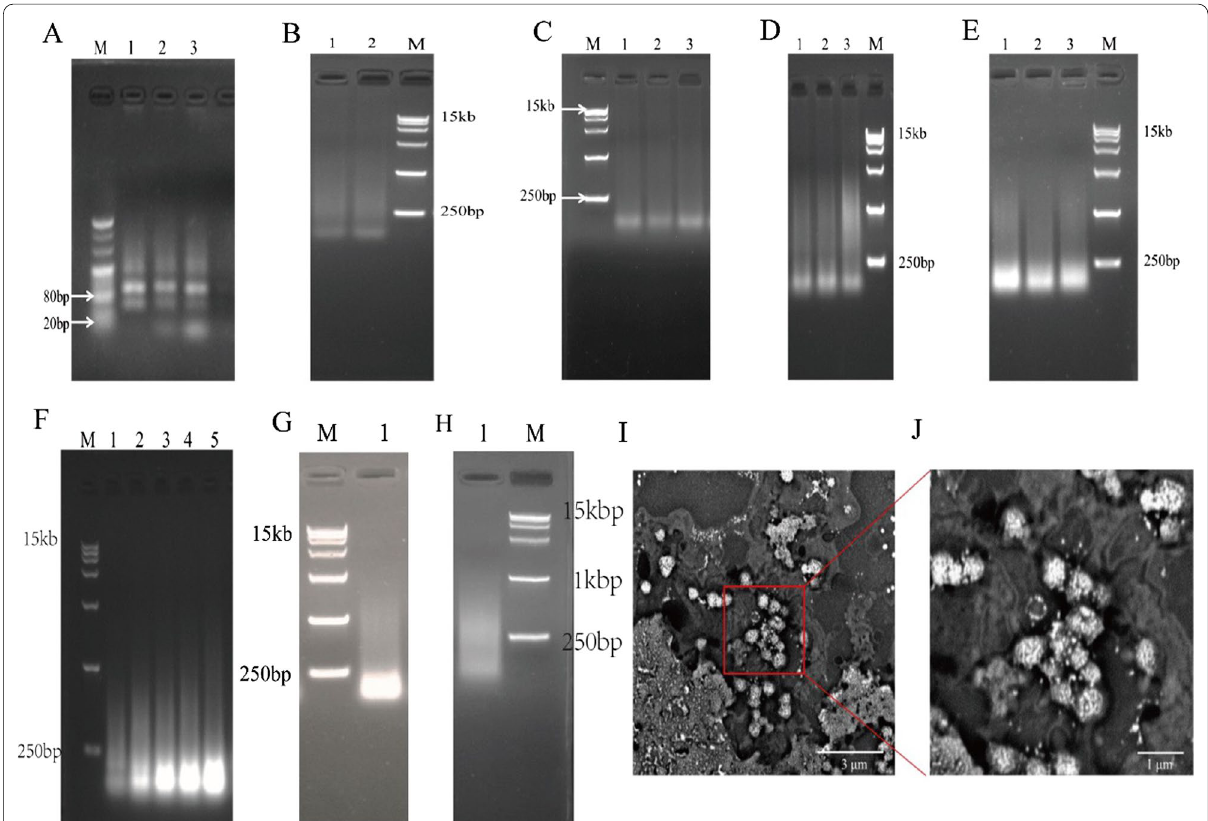
Fig. 2 RCT reaction system optimization and NFs characterization. A Different concentration ratios of template and primer were used to perform the hybridization and ligation reactions. Lane M: DNA ladder, from top to bottom: 500 bp, 400 bp, 300 bp, 200 bp, 100 bp, 80 bp, and 20 bp; lanes 1–3: template to primer concentration ratios of 1:1, 1:2, and 1:3. B Various ligases were used for amplification. Lane M: DNA ladder, from top to bottom: 15 kb, 1 kb, 7500 bp, 5000 bp, 2500 bp, 1000 bp, and 250 bp; lane 1: Taq DNA ligase was used; lane 2: T4 DNA ligase was used. C – E Products amplified with different hybridization times and ligation times. Lane M: DNA ladder, from top to bottom, 15 kb, 1 kb, 7500 bp, 5000 bp, 2500 bp, 1000 bp, and 250 bp; C lanes 1–3: hybridization time 1 h, ligation time: 1 h, 2 h, 3 h. D Lanes 1–3: hybridization time 2 h, ligation time: 1 h, 2 h, 3 h. E Lanes 1–3: hybridization time 3 h, ligation time: 1 h, 2 h, 3 h. F Different concentrations of rNTPs were used for transcription. Lane M: DNA ladder, from top to bottom: 15 kb, 1 kb, 7,500 bp, 5,000 bp, 2,500 bp, 1,000 bp, and 250 bp; lanes 1–5: rNTP concentrations of 2 mM, 4 mM, 6 mM, 8 mM, and 10 mM. G , H Amplification products before and after rolling circle transcription system optimization. Lane 1: RNA; lane M: DNA ladder. I , J SEM images of the